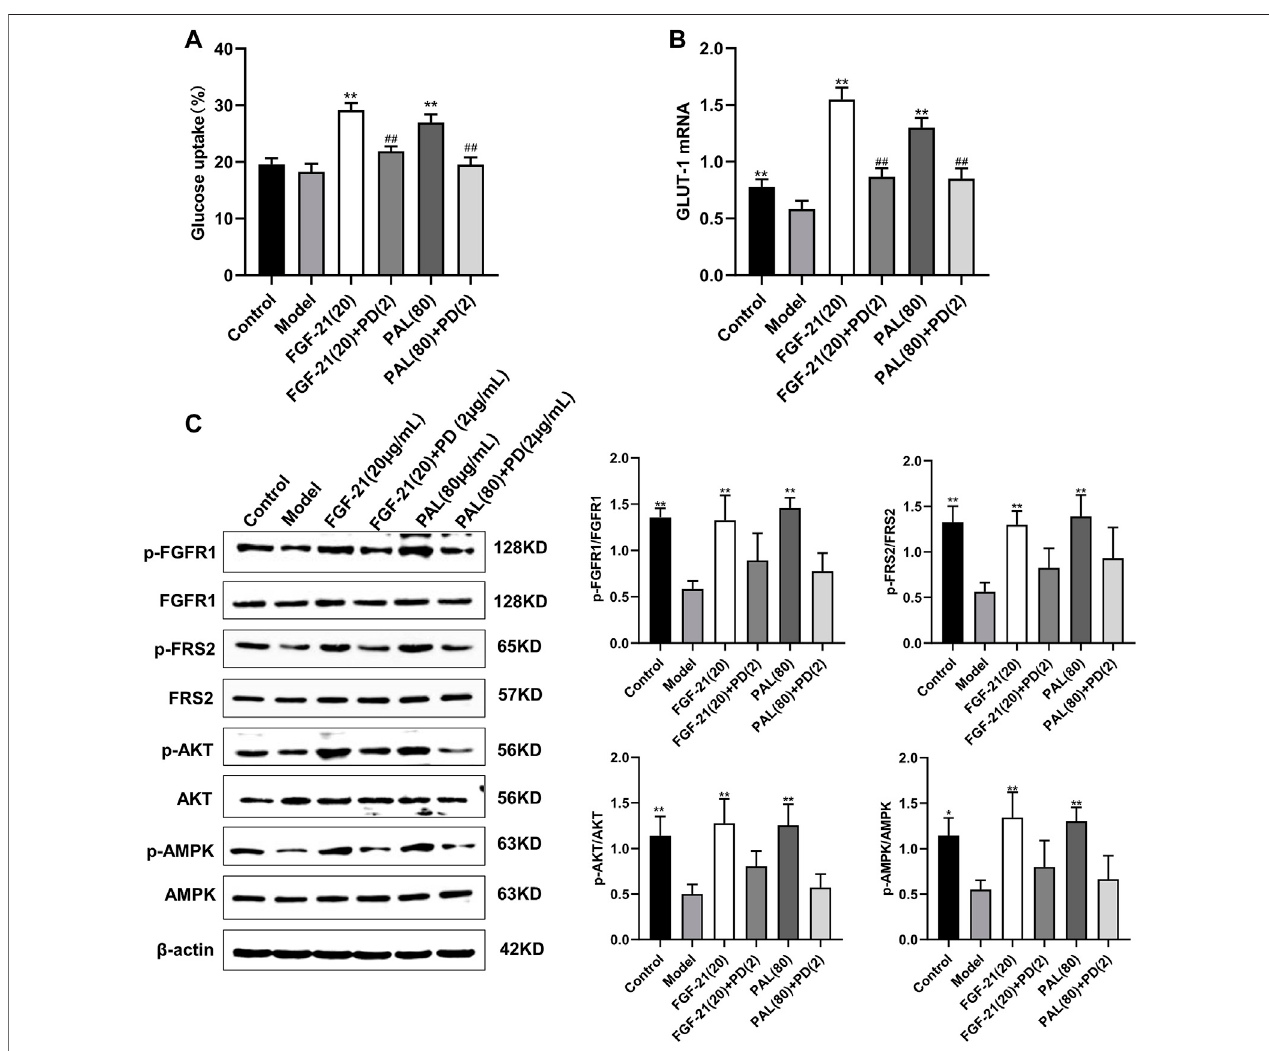
FIGURE5| Treatmentwithan fi broblast growth factor receptor 1(FGFR1) inhibitor blocked theeffectsofpalmatine (PAL) inIRHepG2 cells. (A) glucoseuptakeby IRHepG2cellsafterFGFR1inhibitortreatment. (B) therelativemRNAlevelofglucosetransportertype1(GLUT-1)inIRHepG2cellstreatedwiththeFGFR1inhibitor. (C) quantitative analysis of the expression levels of p-FGFR1 and FGFR1 (p-FGFR1/total FGFR1), p-FRS2 and FRS2 (p-FRS2/total FRS2), p-AKT and AKT (p-AKT/total AKT), and p-AMPK and AMPK (p-AMPK/total AMPK) by western blot. Data are presented as means ± SD, n = 9. * p < 0.05, ** p < 0.01, versus the model group; ## p < 0.01, versus the untreated